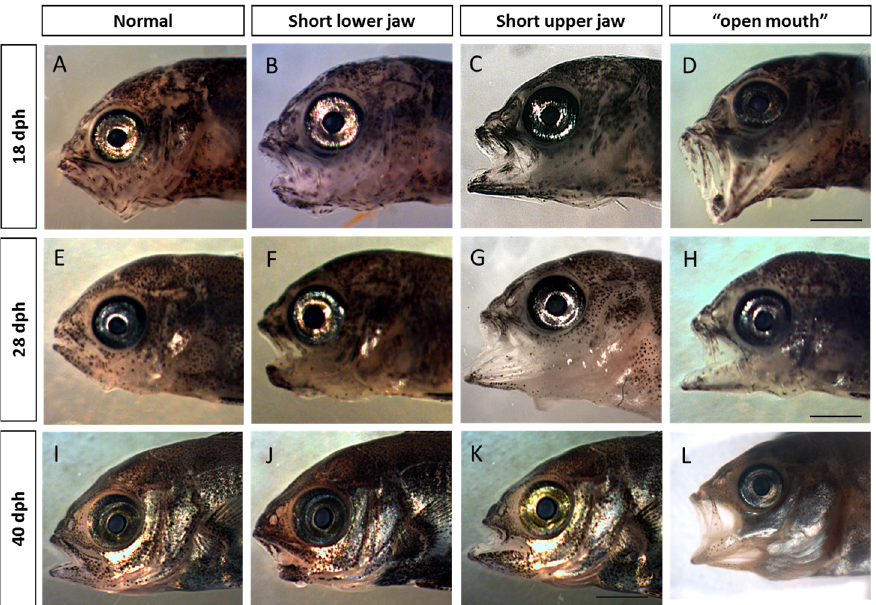
Figure 2. Normal and deformed larval phenotypes. Lateral view of 18, 28, and 40 dph normal larvae ( A , E , I ), larvae with short lower jaw ( B , F , J ), larvae with short upper jaw ( C , G , K ), and larvae with open mouth ( D , H , L ). Scale bar: ( A – D ) 1000 µm, ( E – H ) 2000 µm (2 mm), and ( I – L ) 3500 µm (3.5 mm).